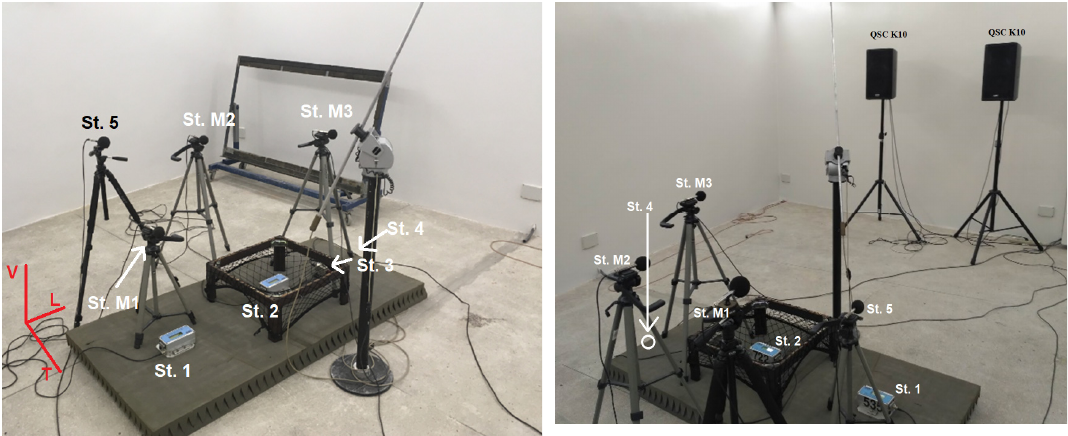
Figure 1. Picture of sensors in the reverberation chamber.